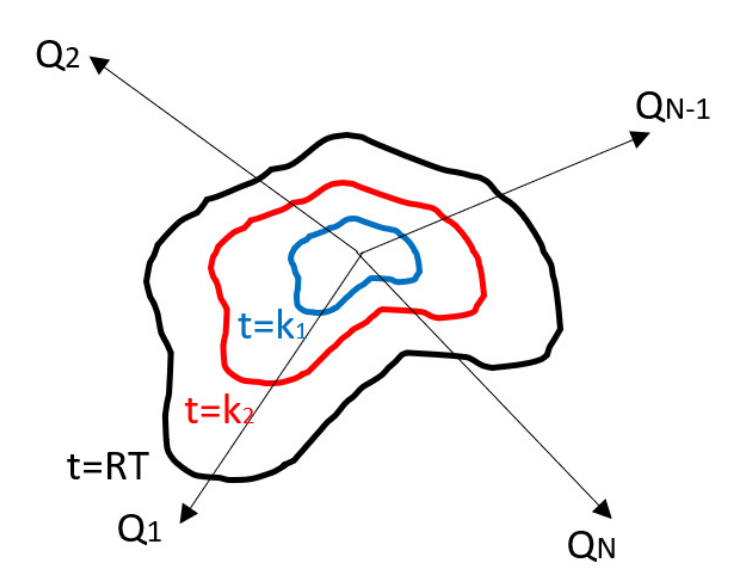
Figure 2. Contour lines of the functionality Q N (t).